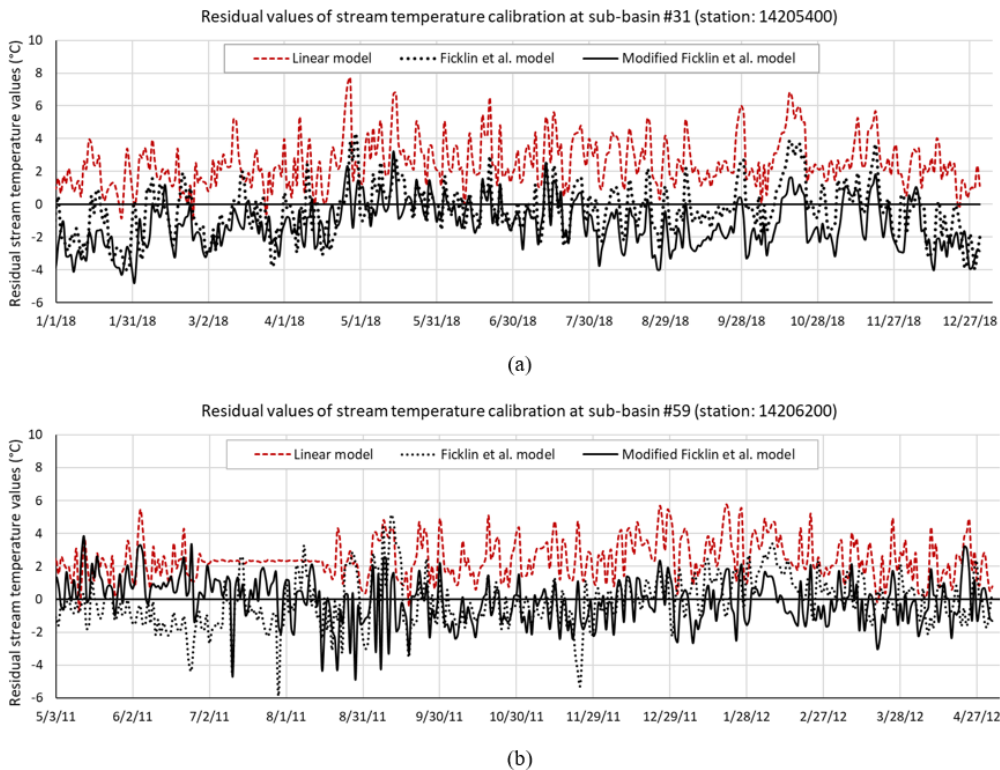
Figure 4. Residual values of stream temperature simulated by the linear model, calibrated by the original and the modified Ficklin et al. model for (a) sub-basin #31 and (b) sub-basin #59 for the last year of the calibrated period.